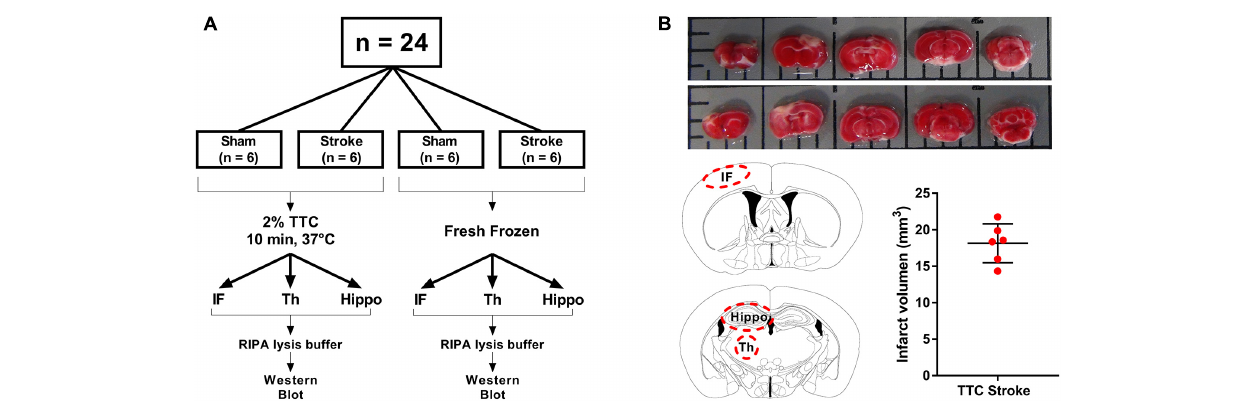
FIGURE 1 | Schematic illustration of the experimental design. (A) Mice were randomly allocated to sham or stroke group. At day 7 post-stroke mice were euthanized and brains were sliced into 2 mm thin sections using a matrix device. Brain samples were divided into two different groups. The brain slides from the first group (TTC+) were stained with 2% TTC at 37 ◦ C for 10 min, then further dissected into infarct (IF), thalamus (Th), and hippocampus (Hippo) and frozen at − 80 ◦ C. The slices from the second group (TTC − ) were dissected and immediately frozen at − 80 ◦ C. (B) Top panel: images of TTC+ mouse brain slices after photothrombotic stroke. After the brain have been sliced, we placed the 2 mm section on a grid mat. Once we have taken a picture of one side (rostral, row 1) of the brain, we flipped the sections and take a picture of the other side (caudal, row 2). Bottom panel: schematic illustration showing the location of the examined regions (IF, Th, and Hippo) (left). Quantification of the IF volume in TTC+ stroke mice (right).